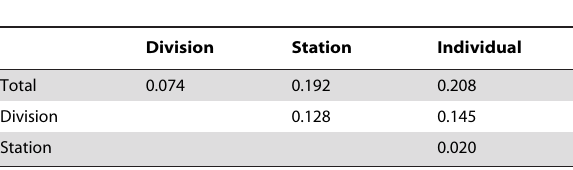
Table 2. Hierarchical F statistics among divisions, among sampling stations within divisions and among individuals within